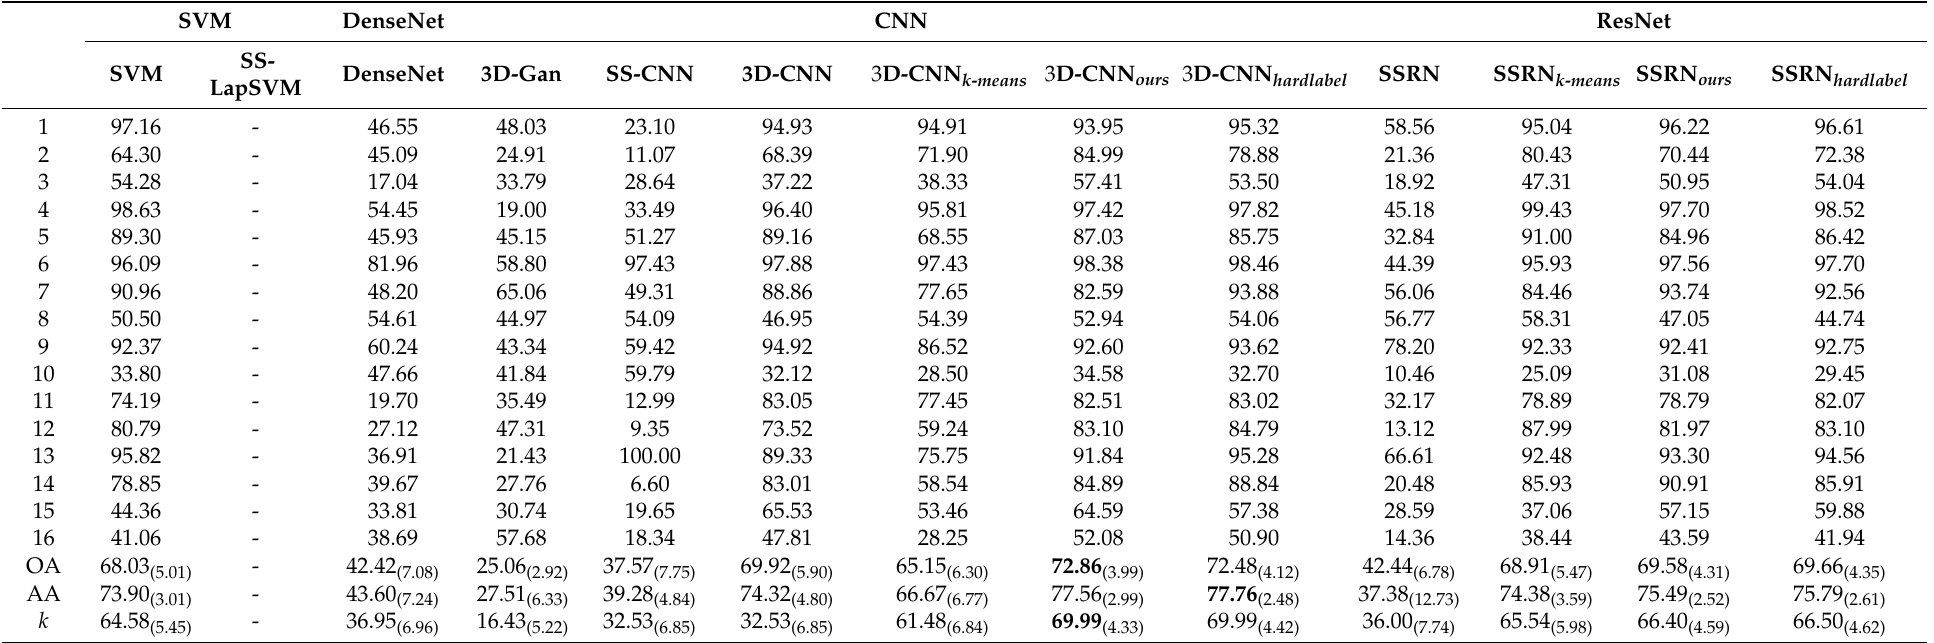
Table 9. Classification accuracy (%) for all methods with one training sample on the Salinas dataset. The symbol ‘-’ means the method failed to